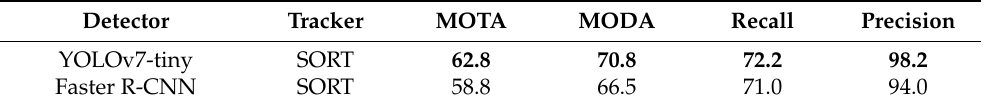
Table 1. CLEAR MOT metrics of YOLOv7-tiny and Faster-RCNN detectors with the SORT tracker.